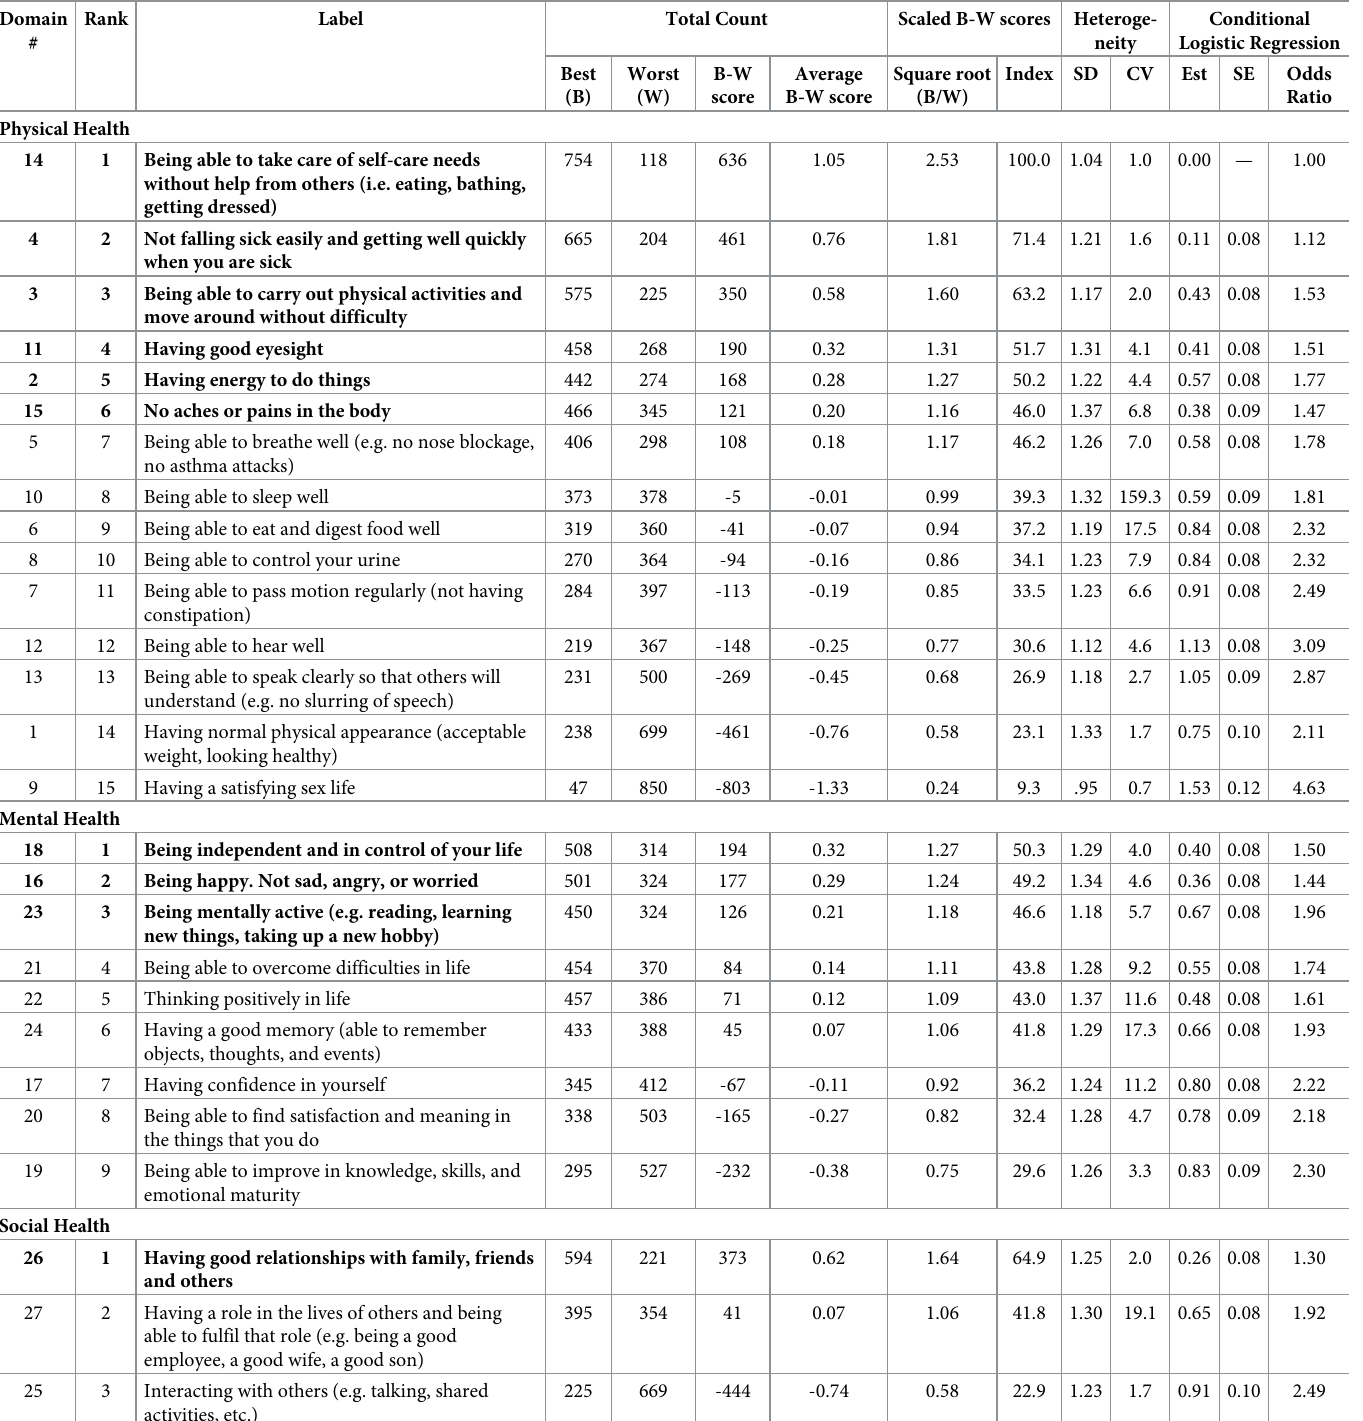
Table 4. Summary of best-worst scaling survey